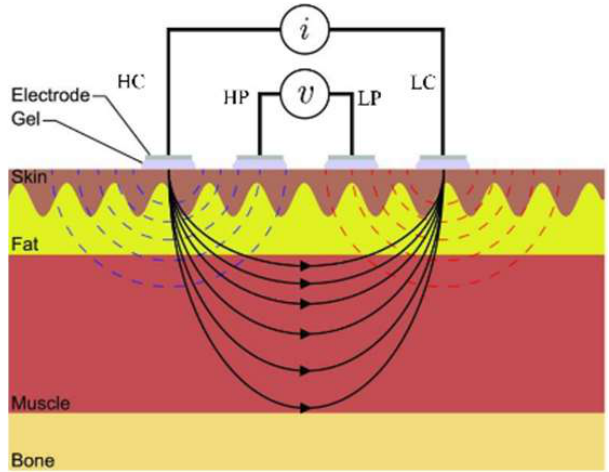
Figure 2. Placements of four electrodes and the distribution of electric field under the EIM measure- ment.